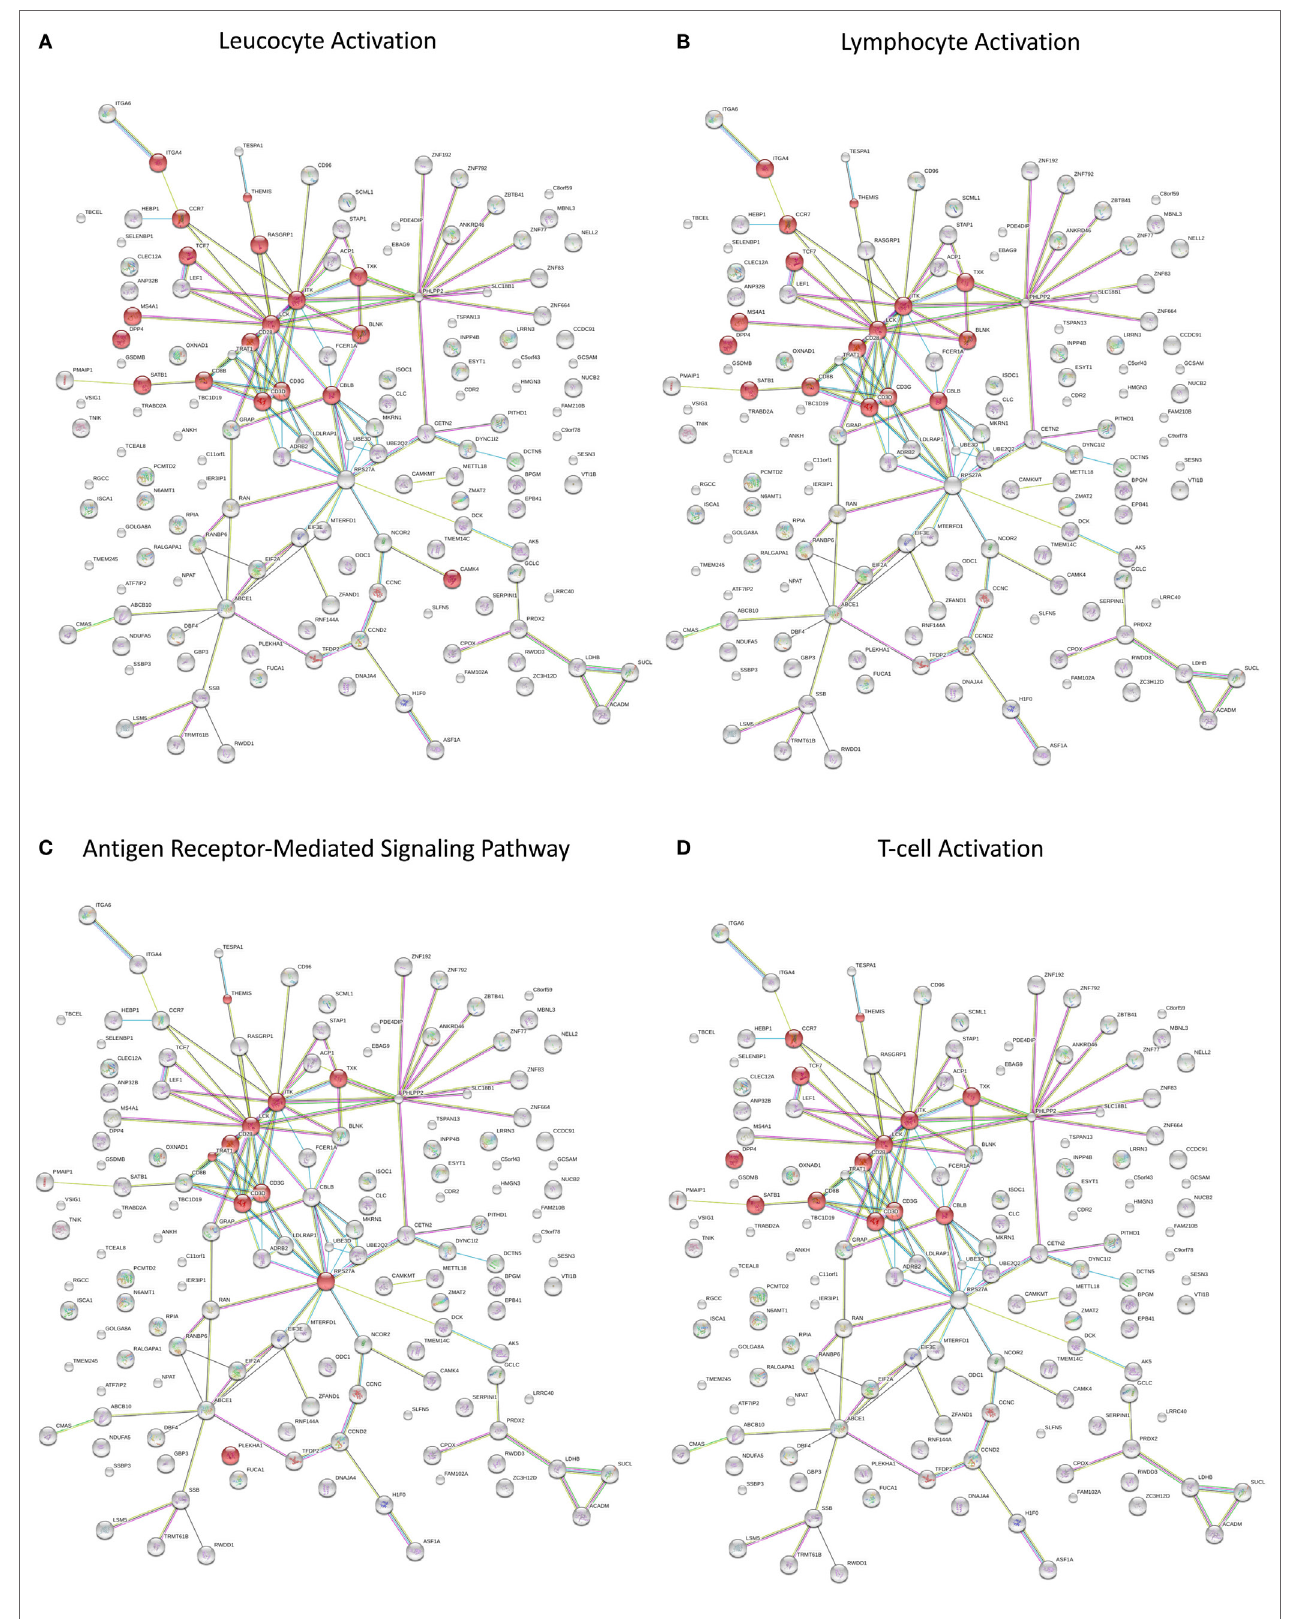
FiGURe 4 | (a–D) Network visualization of functionally enriched GO biological processes in significantly downregulated genes from the